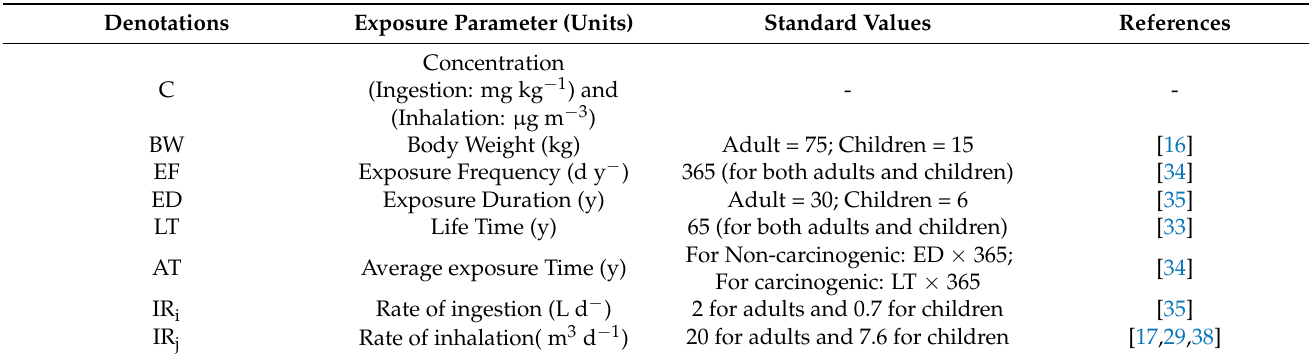
Table 3. Description of exposure parameters of ingestion and inhalation.